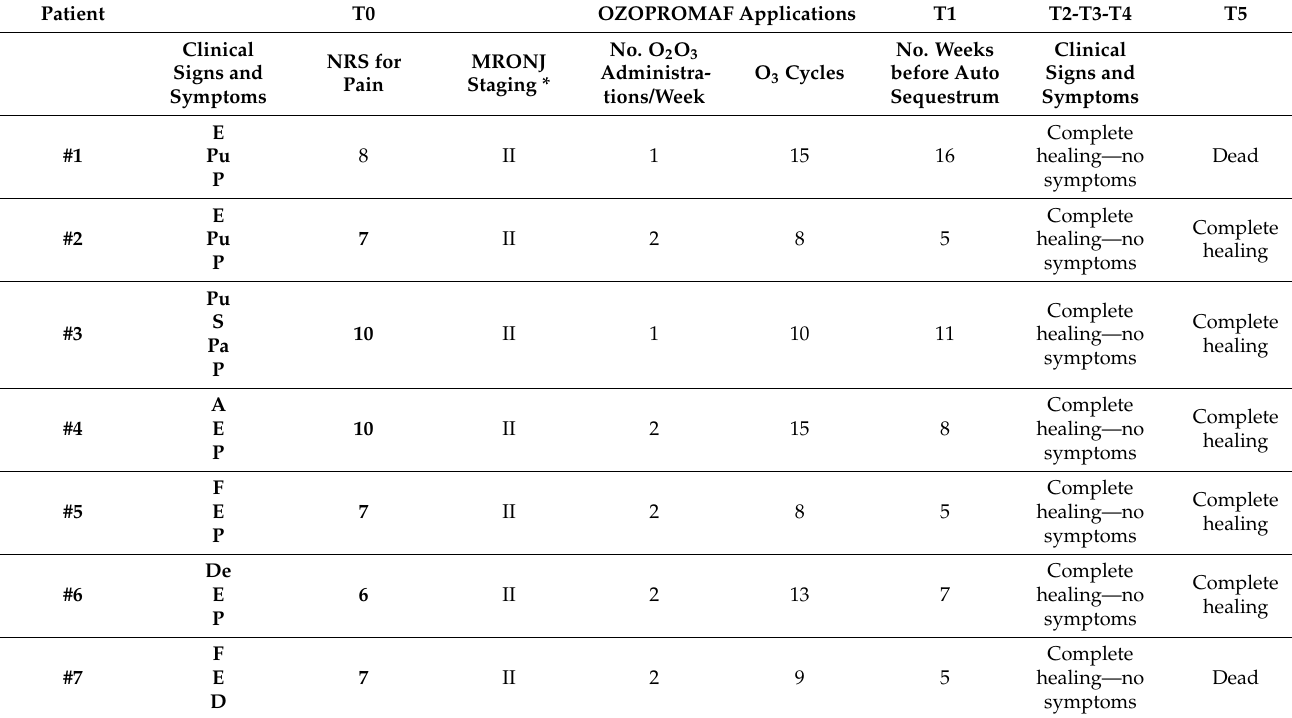
Table 3. Detailed results of patients treated with OZOPROMAF